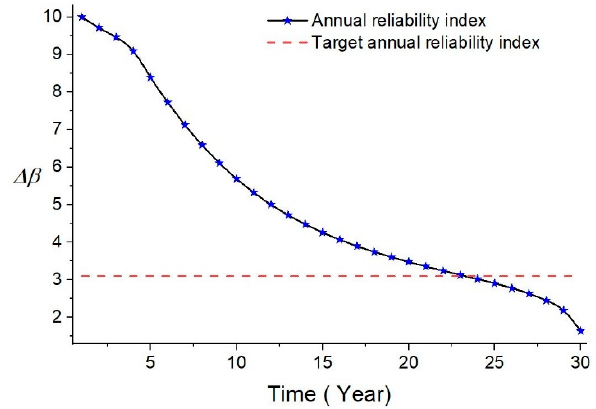
Figure 14. Annual reliability index trend.